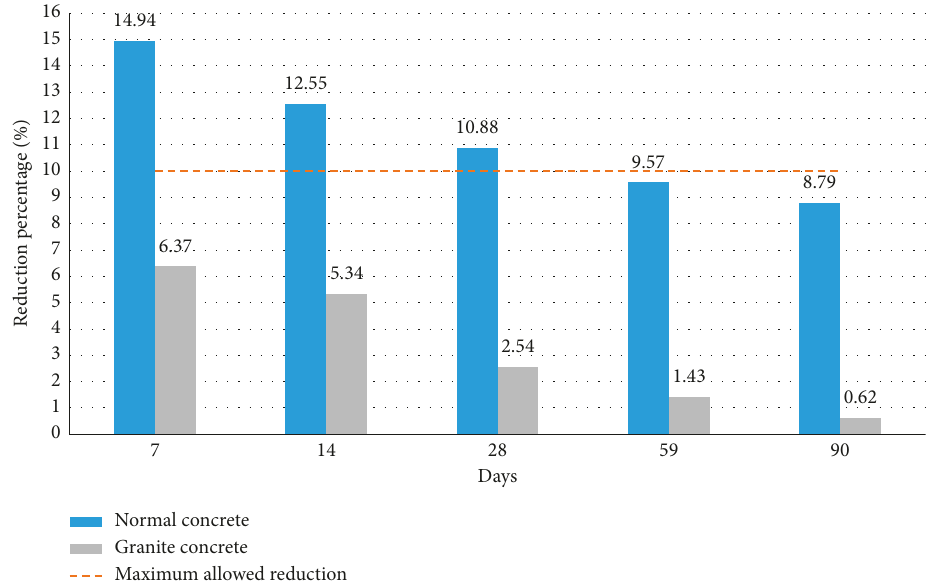
Figure 10: Percentage of strength reduction in the normal concrete and granite concrete with the maximum allowed limitation.